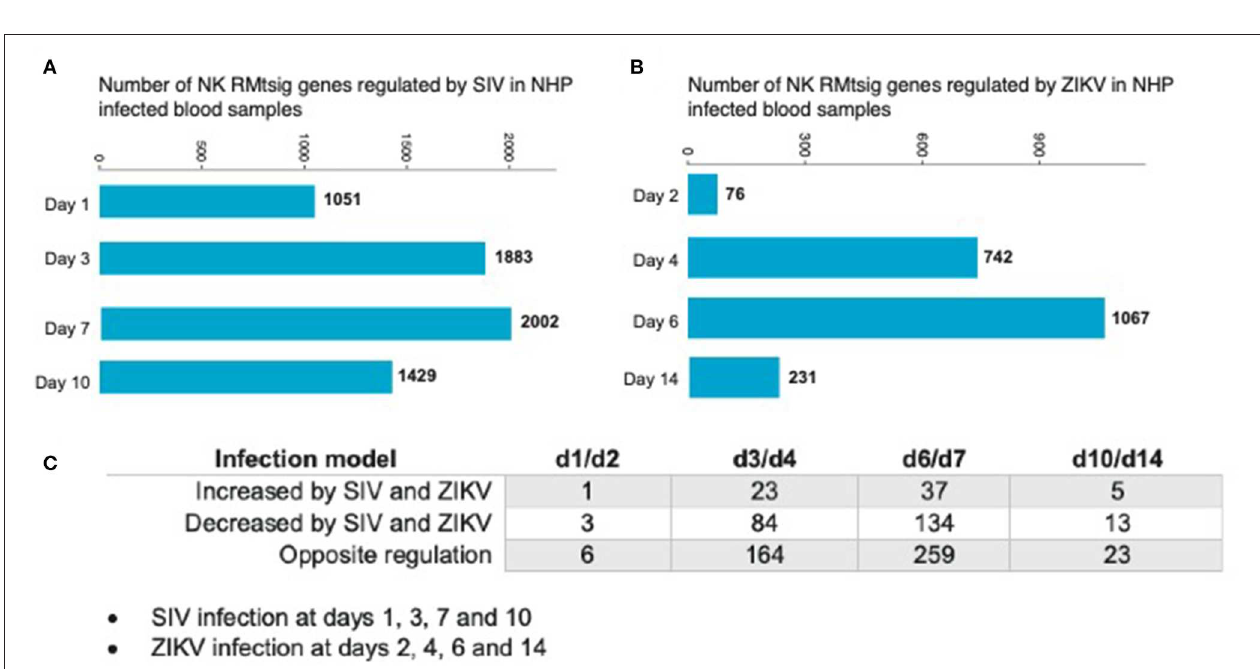
FIGURE 7 | NK RMtsig is modulated following SIV and ZIKV infections in two independent NHP cohorts. (A,B) Barplots of the number of NK RMtsig genes that are modulated by SIV (A) or ZIKV (B) at different time points following infection. (C) Number of NK RMtsig genes that are commonly increased or decreased by SIV and ZIKV at different time points following